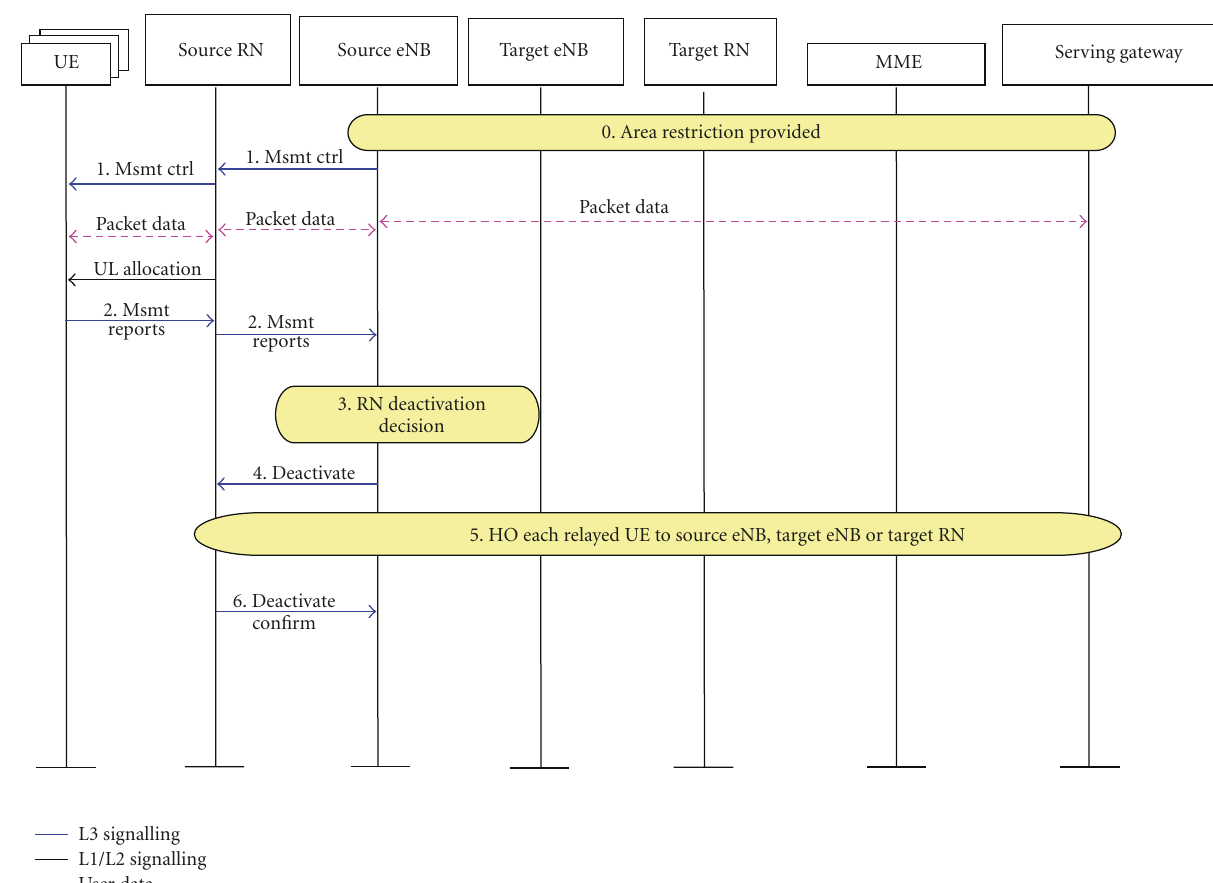
Figure 4: Deactivation of an RN in an LTE network that supports dynamic RN